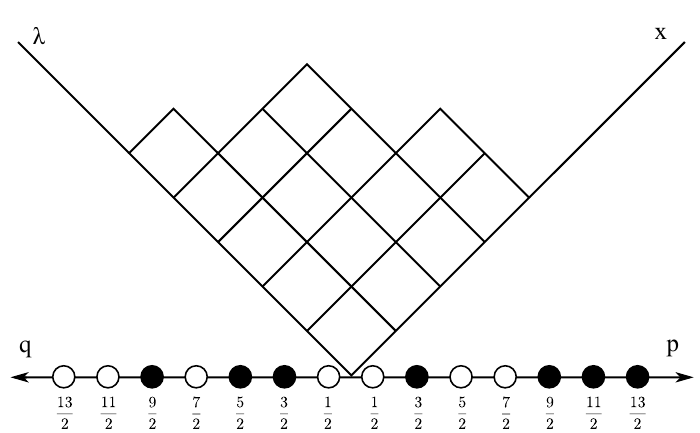
Figure 8 . A rotated Young diagram corresponding to the partition λ . The lower axis is labelled in terms of the half integer Frobenius coordinates q (both positive). There is a piecewise-linear j , p i curve starting with the diagonal axis on the left, running along the top border of the diagram of the partition and ending with the diagonal axis on the right. It is clear that the contour of λ has slope − 1 wherever there is a white pebble, and has slope +1 in the intervals where there is a black pebble. The association of sequences of pebbles to a Young diagram is denoted as a Maya diagram . The collection of all the Maya diagrams is into 1-1 correspondence with the fermionic Fock space. We are especially interested to understand the limiting shape of the contour as the number of boxes tends to infinity, while their size tends to zero (keeping the area of the diagram fixed). See figure 1 for the limiting shape corresponding to the Plancherel